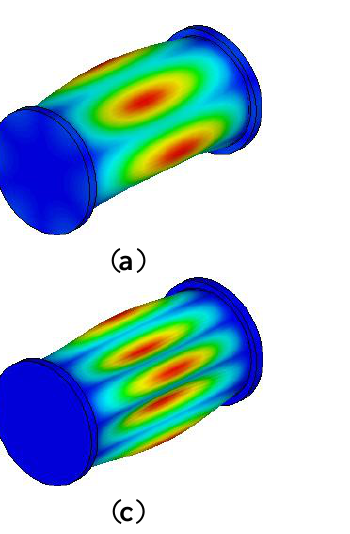
Figure 7. Fundamental mode shapes of underwater cylindrical shell structure. ( a ) 1st mode, ( b ) 2nd mode, ( c ) 3rd mode, and ( d ) 4th mode.